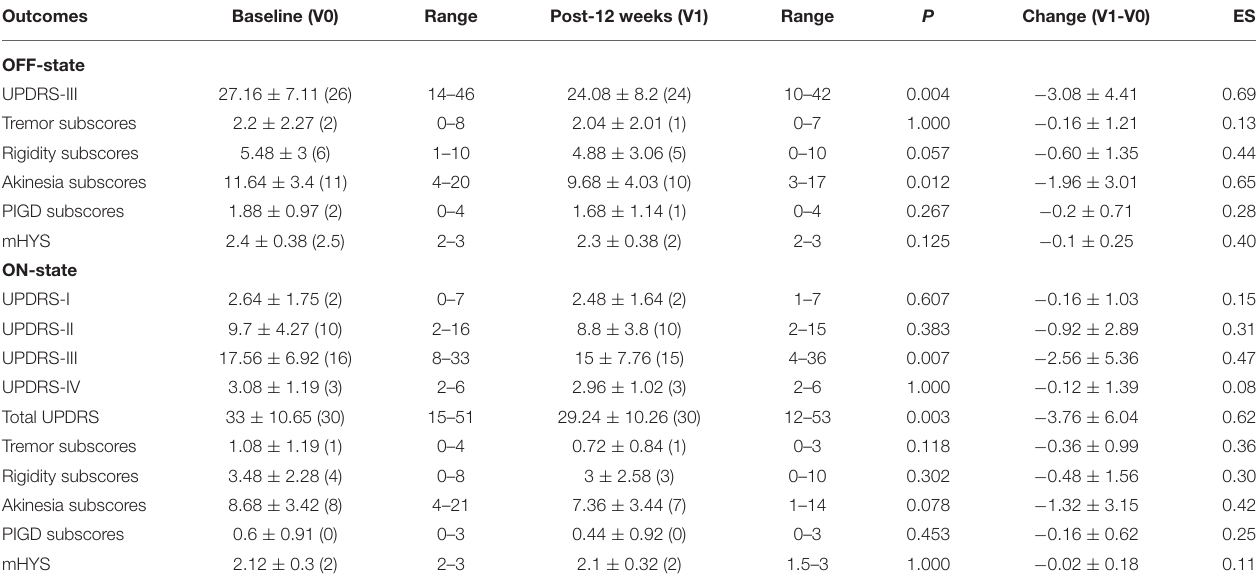
TABLE 2 | The OFF- and ON-states of the unified Parkinson’s disease rating scale of patients with PD at baseline and after 12 weeks of intervention. Outcomes